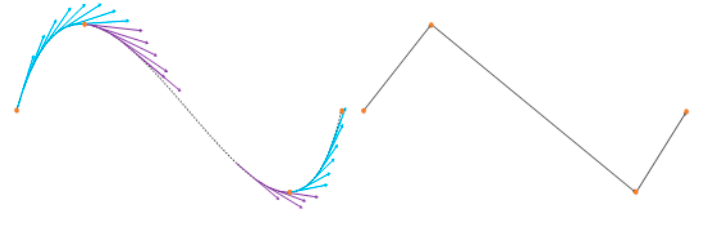
Figure 8. Vertical slope of a curved line.